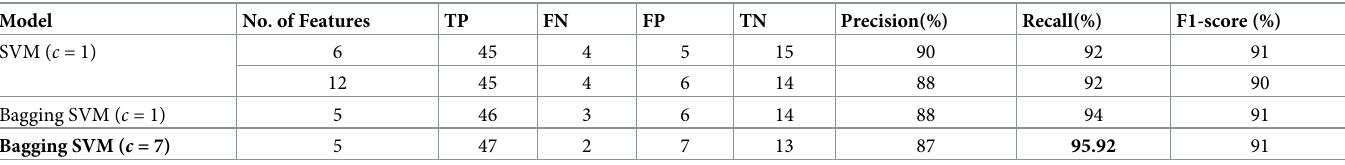
Table 10. Elements of confusion matrix for SVM and bagging SVM.